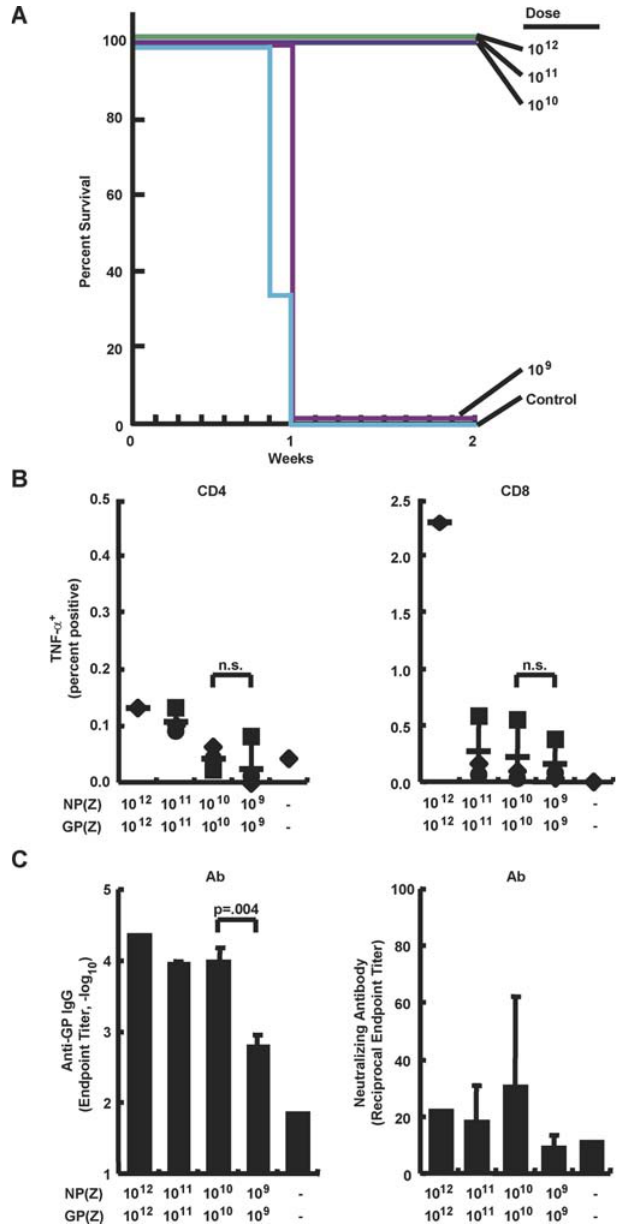
Figure 3. Determination of Lowest Vaccine Dose for Immune Protection against Ebola Virus Challenge by Adenoviral Vector GP/NP Vaccine (A) Kaplan-Meier survival curve of macaques: Immunization was with rAd vectors expressing GP(Z) and NP(Z) (10 9 –10 11 , three animals per group; control and 10 12 , one animal each), and challenge was performed with the Kikwit strain of Zaire ebolavirus as in Figure 2A. (B) Immune responses in immunized animals. Intracellular flow cytometry was performed to quantify TNF- a production from Ebola-specific CD4 þ (left graph) or CD8 þ (right graph) lymphocytes, respectively, from animals immunized as indicated. Immune responses were measured at 3 wk postimmunization. Circles, diamonds, and squares indicate responses for individual animals. Horizontal line indicates the average of individual responses in the immunization group. Results represent the percent cytokine positive in the gated lymphocyte group and background stimulation (DMSO alone) has been subtracted from each sample ( p - values obtained using unpaired Student’s t -test; n.s., not significant). (C) Antibody responses in immunized animals. Anti-GP ELISA titers (left graph) and serum neutralizing antibody responses (right graph) were measured as described in Methods. DOI: 10.1371/journal.pmed.0030177.g003